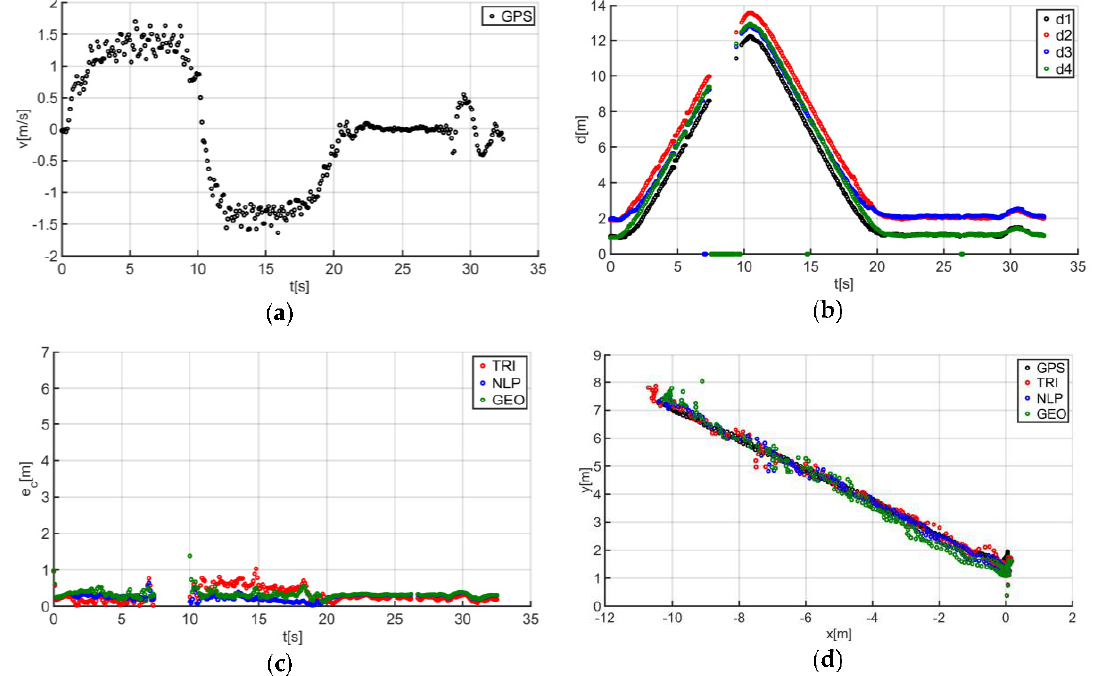
Figure 15. Test results no. 2: ( a ) human guide speed v p (t) and ( b ) filtered distance from anchors d i (t), i = 1, 2, 3, 4; ( c ) course of total location errors e c (t) and ( d ) location of the human guide y p (t) = f(x p (t)).